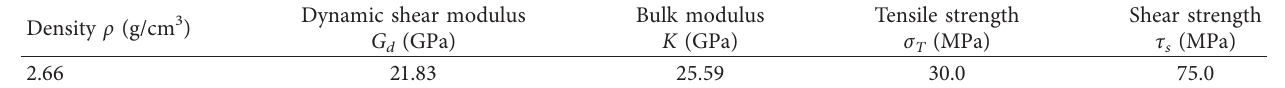
Table 1: Average dynamic mechanical parameters of granite.